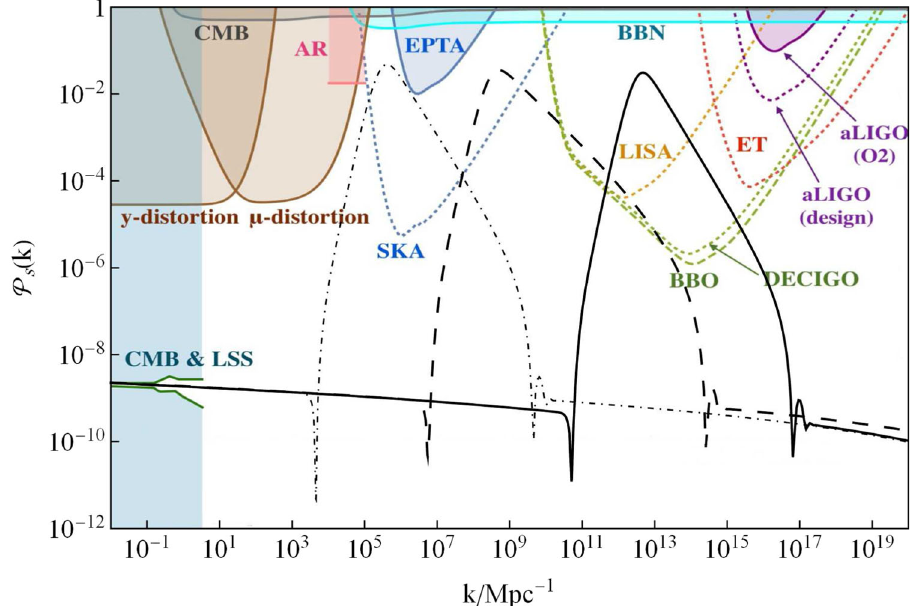
Fig. 3 The curvature power spectra founded by solving numerically the Mukhanov–Sasaki equation versus the comoving wavenumber k for Case 1 (solid black line), Case 2 (dashed black line), and Case 3 (dash-dotted black line). The colored shaded regions are excluded by the current observations and the colored dashed lines show the expected limits from the future experiments [197]